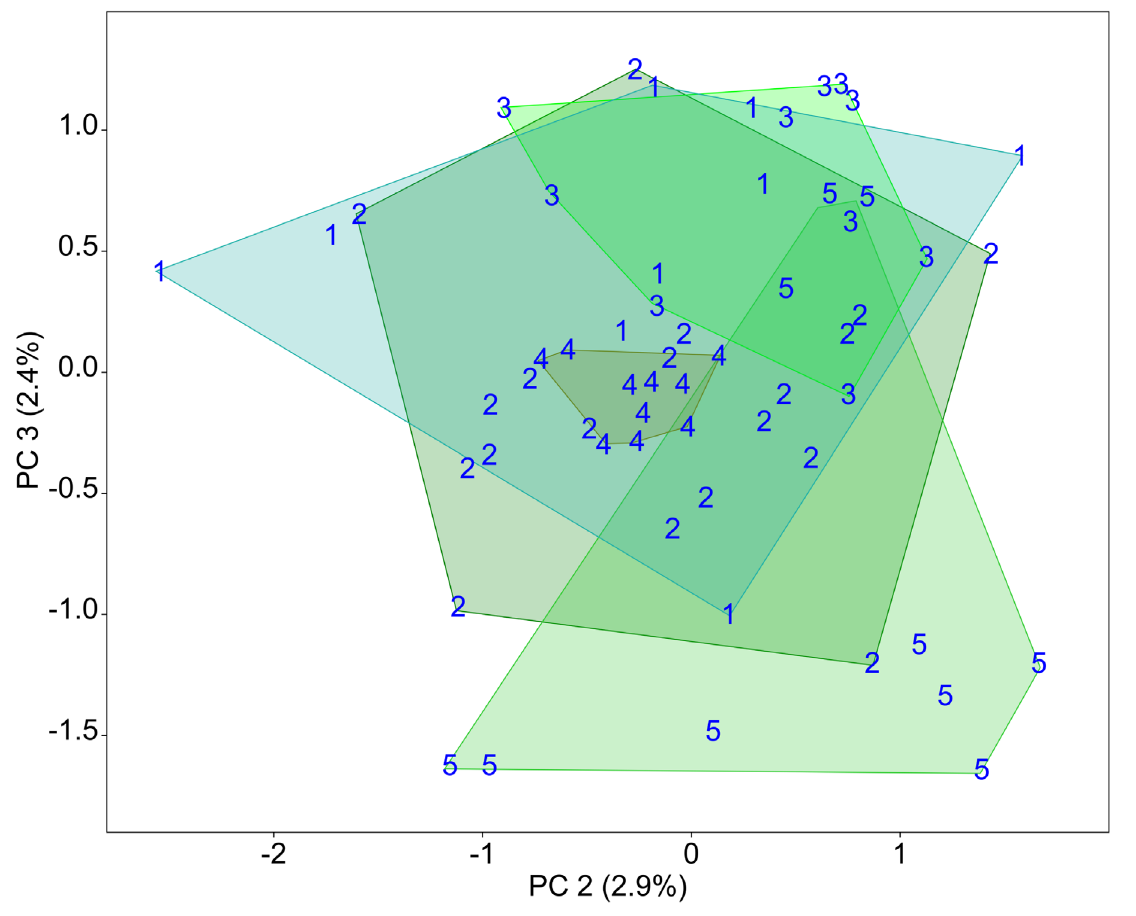
Fig. 4 . The result of statistical analysis of morphometric characters of type and non-type specimens of Cottus cyclophthalmus sp. nov. from rivers Krasnaya, Neris, Šerkšnė, Siesartis, and Žeimena (method of principal components was used). The numbers correspond to the places where the sculpins were caught, as indicated on the map (Fig.